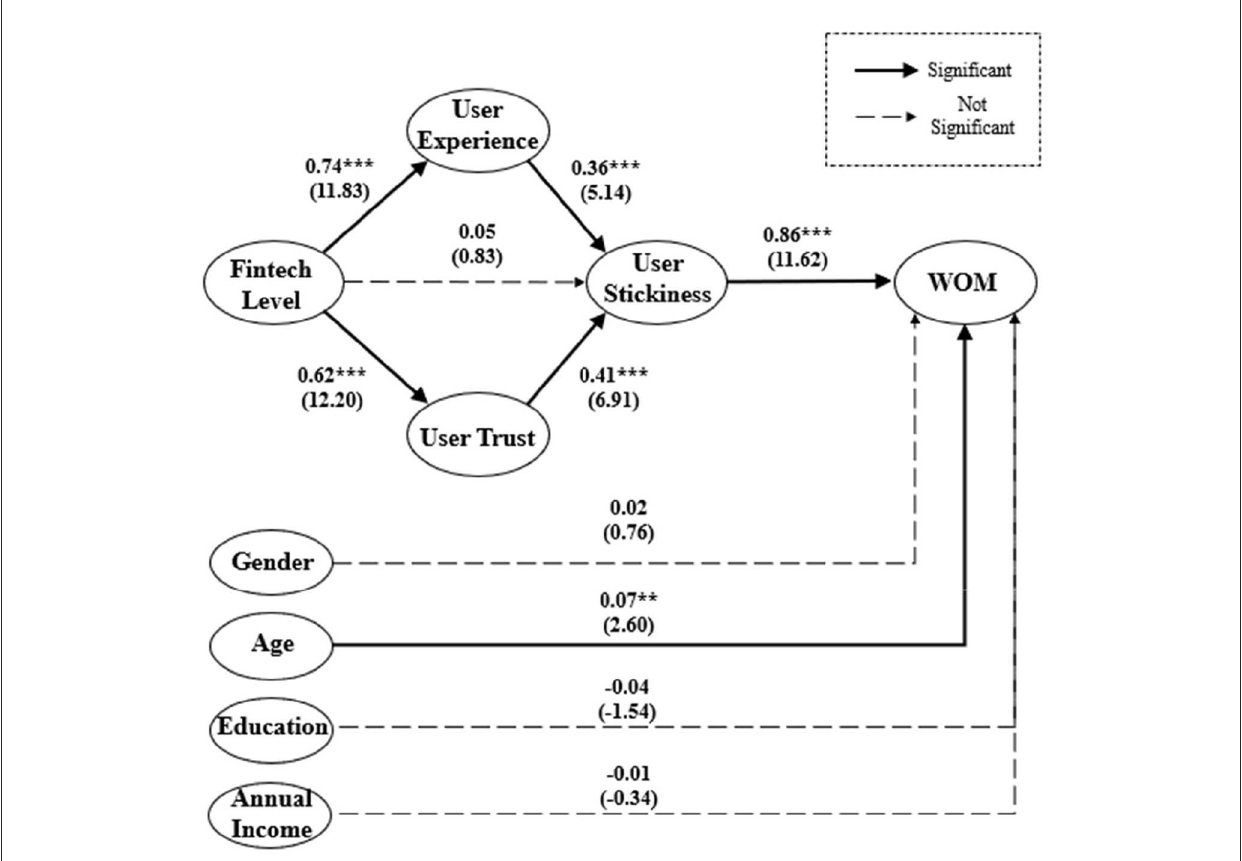
FIGURE2 Structural equation model with standardized estimates ( *** significant at 0.001 level; ** significant at 0.01 level). χ 2 /d.f. = 4.022, p ≤ 0.001; GFI = 0.894; CFI = 0.903; IFI = 0.904, RMR = 0.036; RMSEA = 0.064.